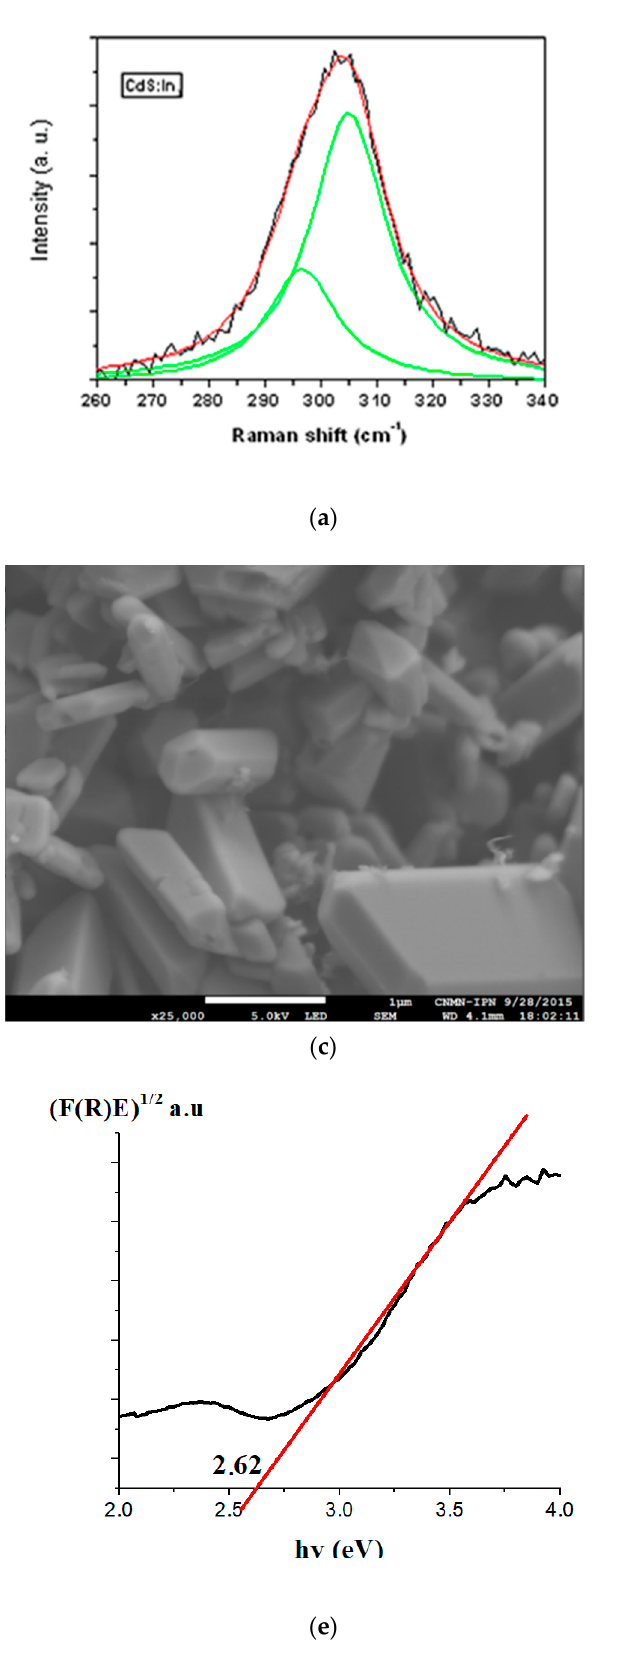
Figure 1. CdS characterization. ( a ) RAMAN spectrum (260–340 cm − 1 ), ( b ) RAMAN spectra (500–640 cm − 1 ), ( c ) SEM micrograph, ( d ) TEM image, ( e ) diffuse reflectance spectrum, and ( f ) BET adsorption-desorption loop.